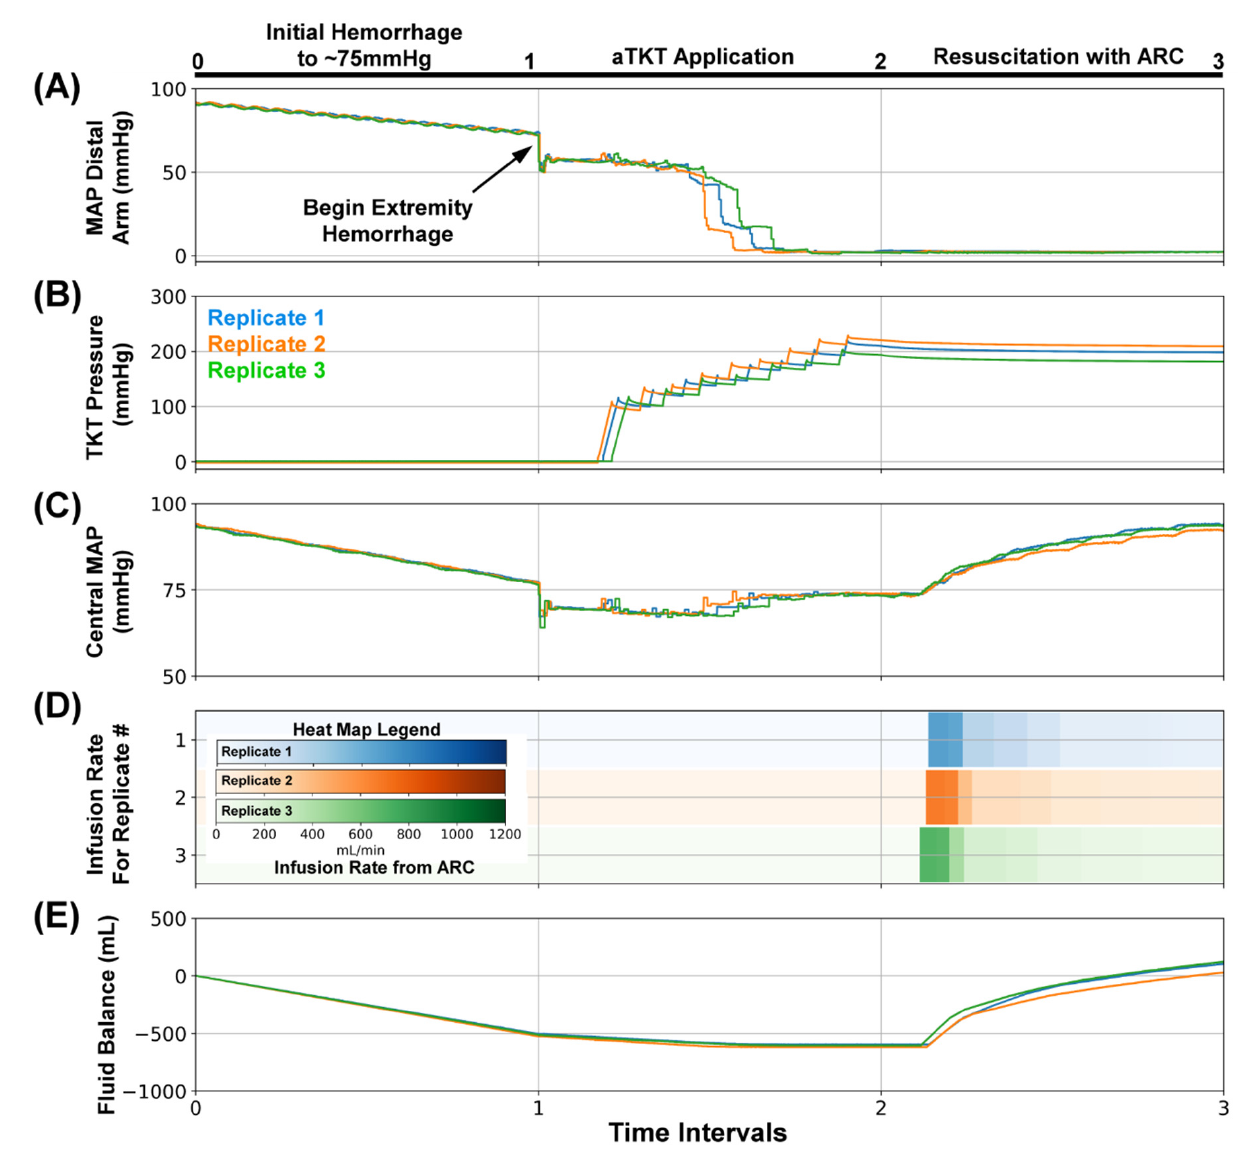
Figure 5. SACM Testing Scenario #1. After (0–1), the initial hemorrhage reduced blood pressure to approximately 75 mmHg, (1–2) extremity hemorrhage was stopped by aTKT, (2–3) followed by ARC-based resuscitation to 95 mmHg. Aligned results are shown for ( A ) MAP distal to the bleed site (mmHg, PT2), ( B )Tourniquet Cuff pressure (mmHg), ( C ) Central MAP (mmHg, PT1), ( D ) Resuscitation flow rate (mL/min), and ( E ) overall system fluid balance (Infused Volume—Hemorrhage Volume, mL). Three individual replicates are shown to illustrate the similarities and difference between each replicate